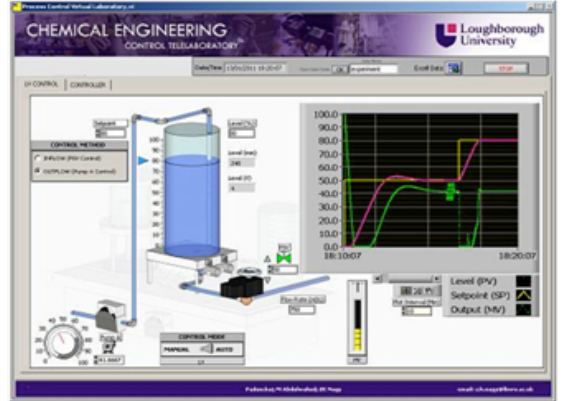
Figure 2. The Graphical User Interface (GUI) of the Process Control Virtual Lab